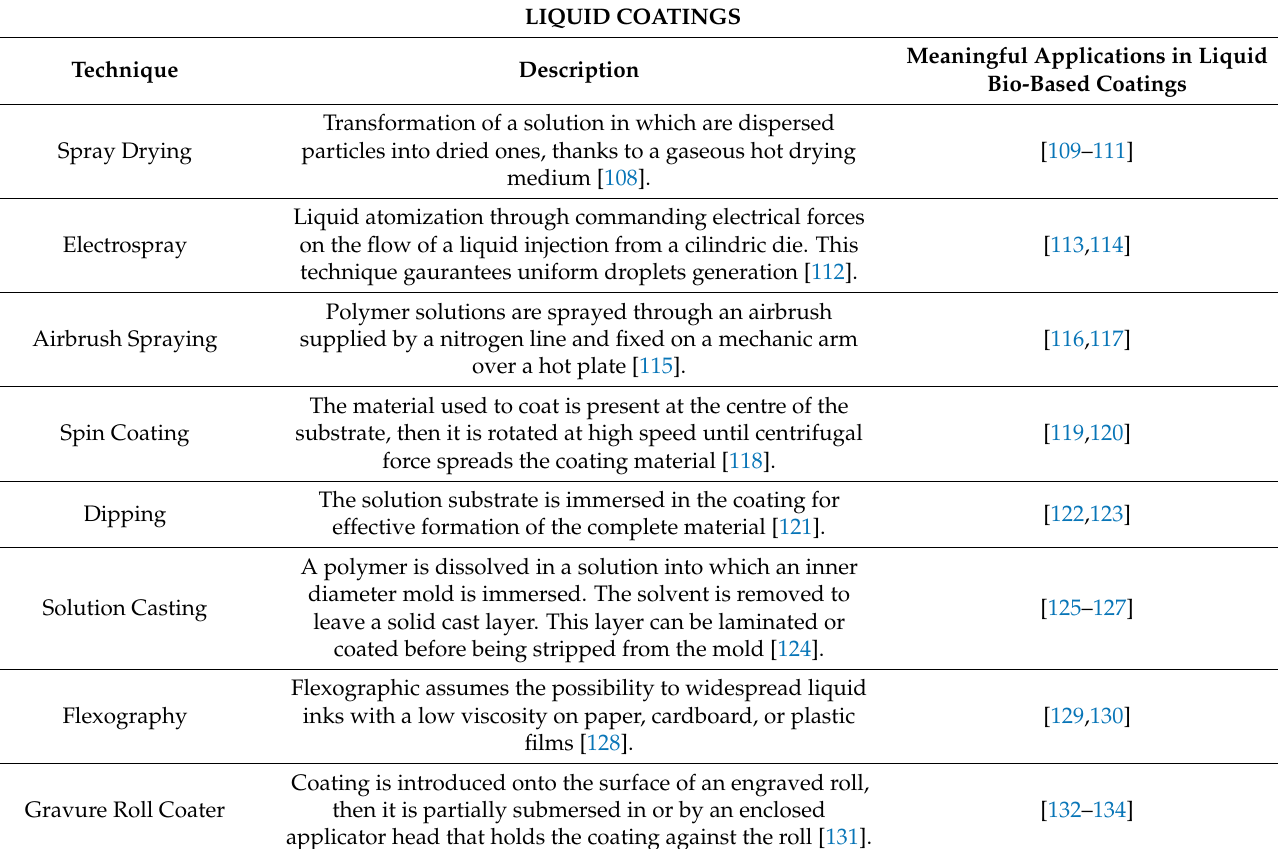
Table 2. Liquid coatings techniques and main results regarding liquid bio-based